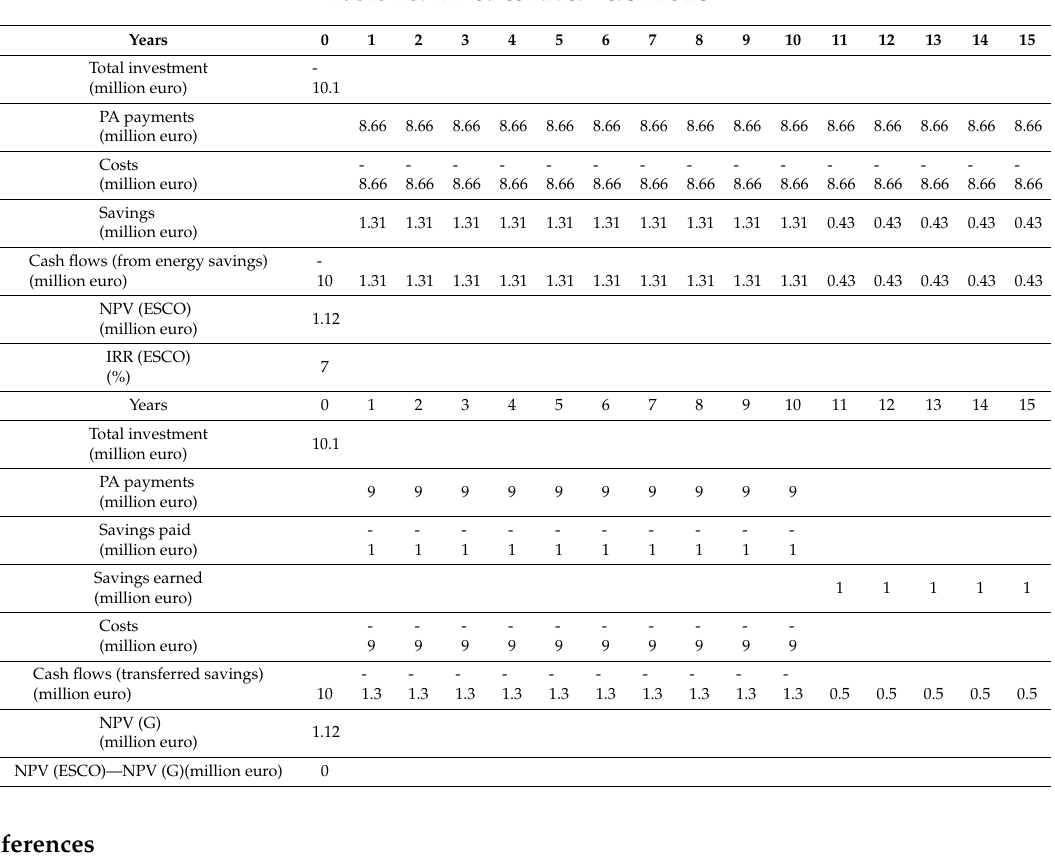
Table A3. Mixed contract—cash